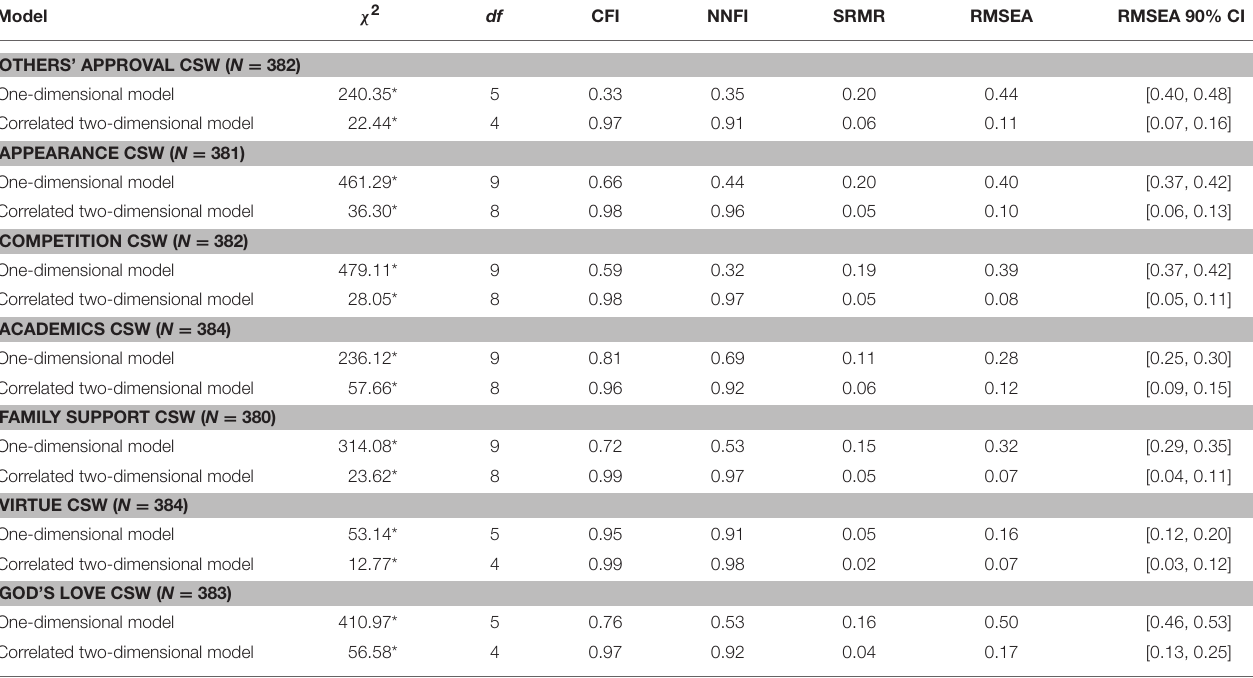
TABLE 2 | Goodness-of-Fit Summaries for Confirmatory Factor Models. Model χ